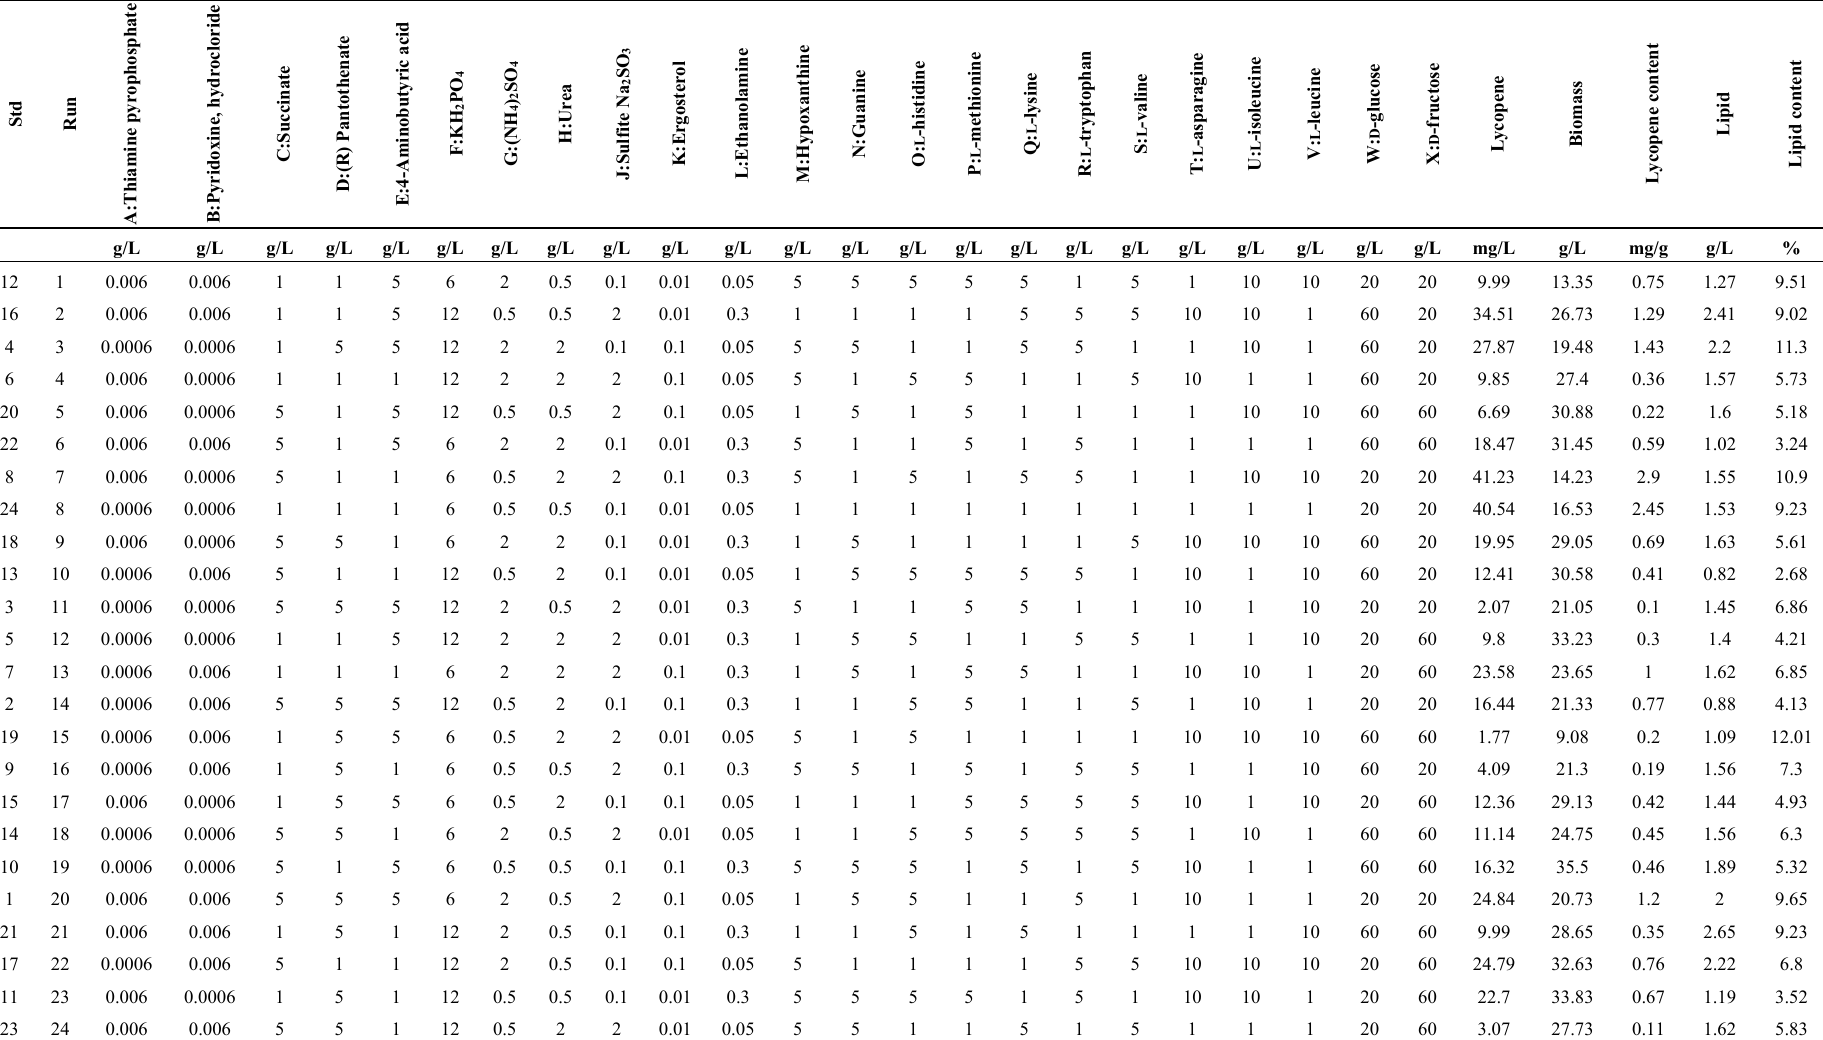
Table 4. Matrix of Plackett-Burman design of FBA predicted medium